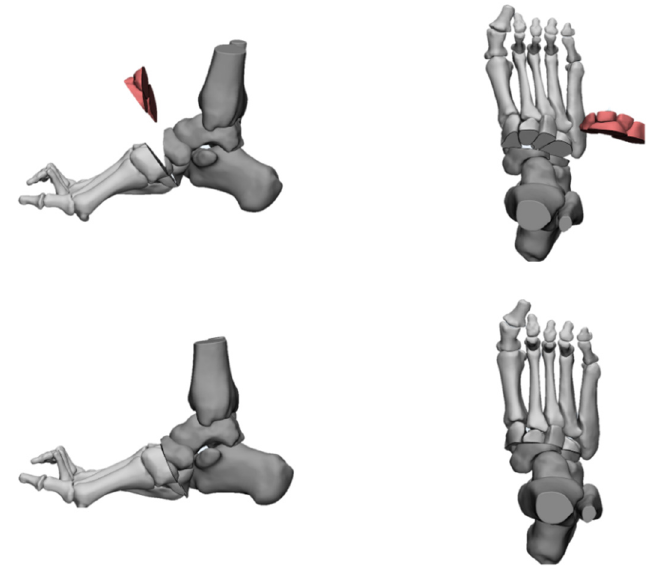
Figure 11. The Cole Osteotomy.